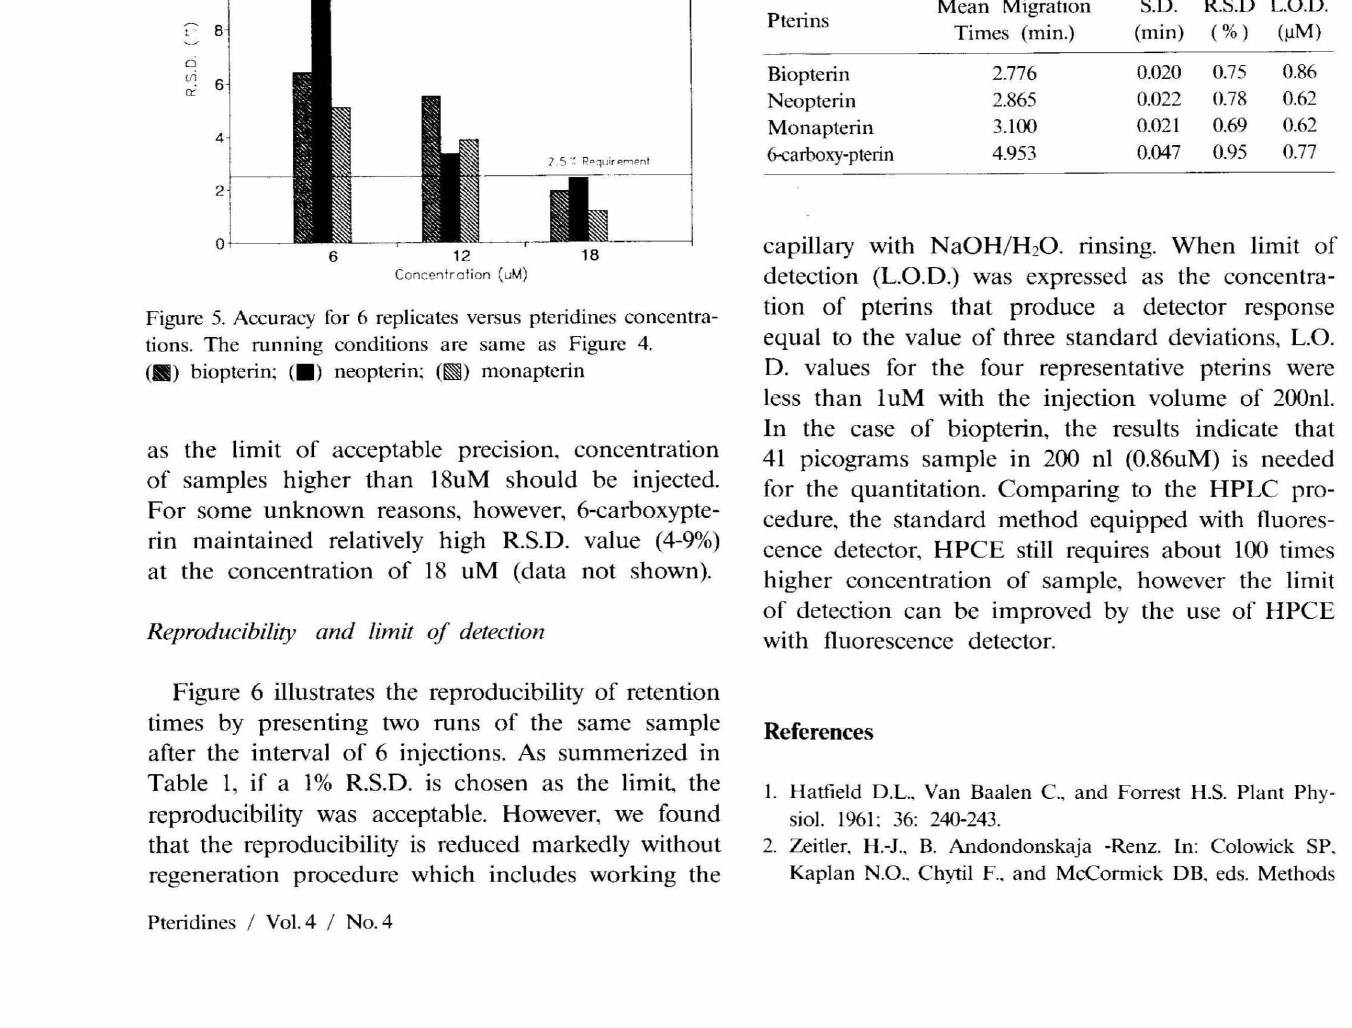
Table 1. Means, standard deviations (S.D.) and relative stan dard deviations (R.S.D.) of migration times and limit of detec tion (L.O.D.) for pterins (n =9).